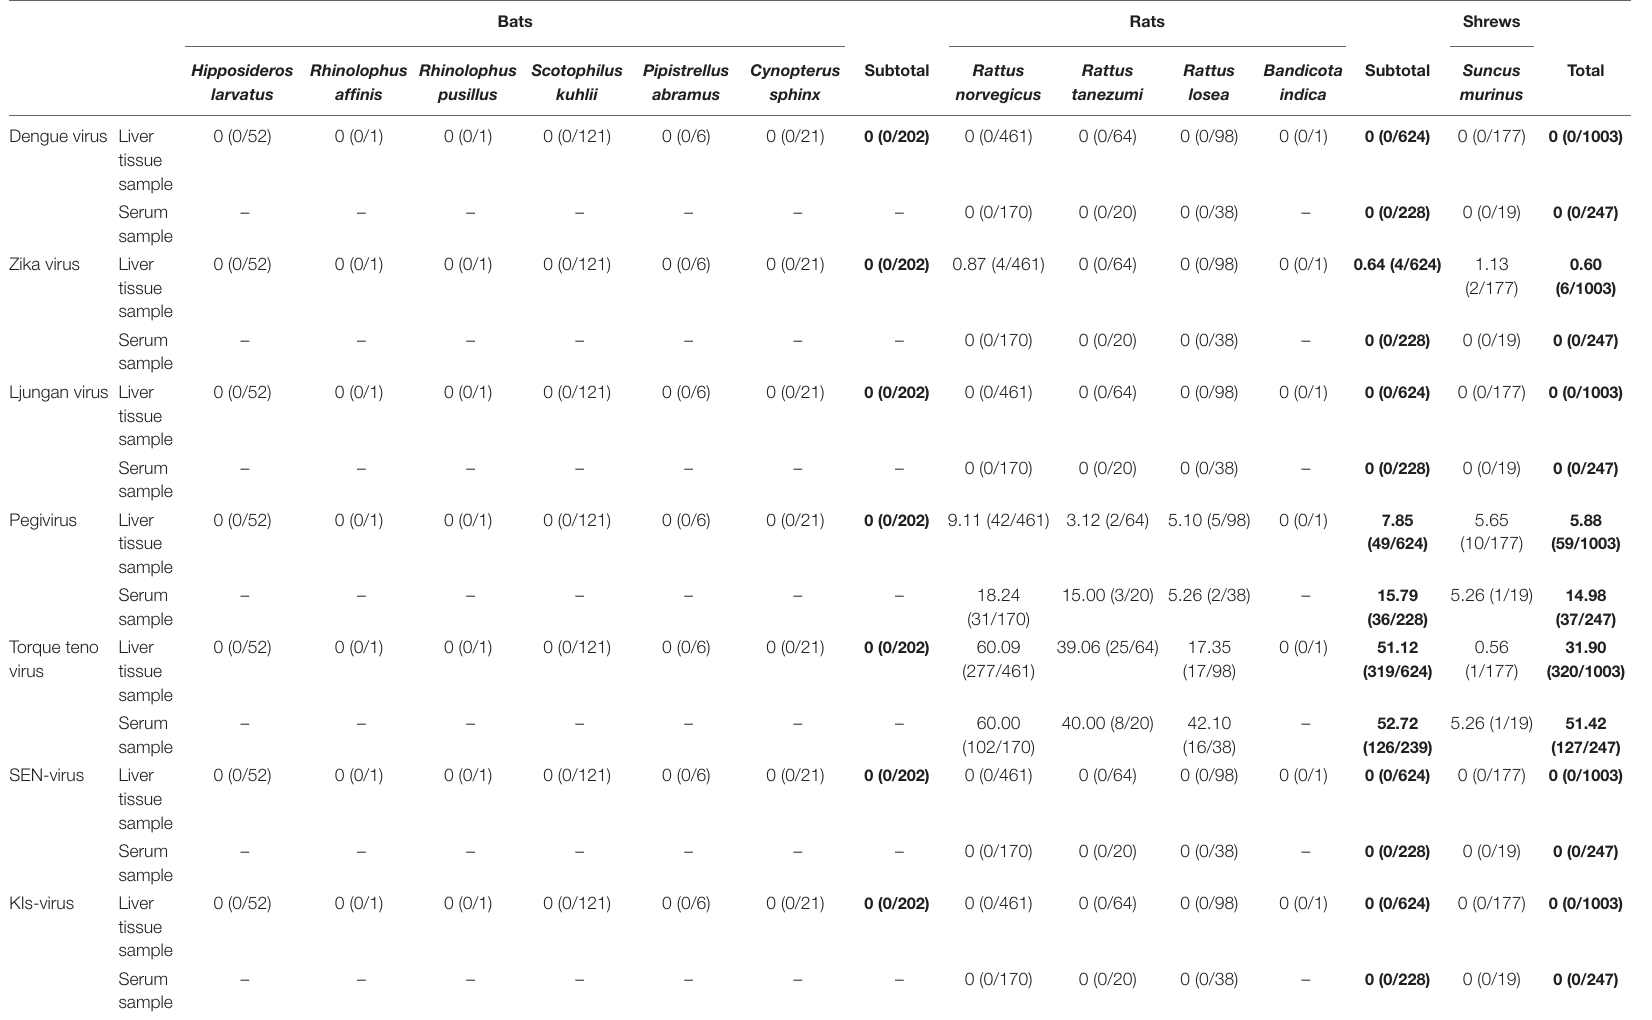
Bold values indicates the total and subtotal numbers of the